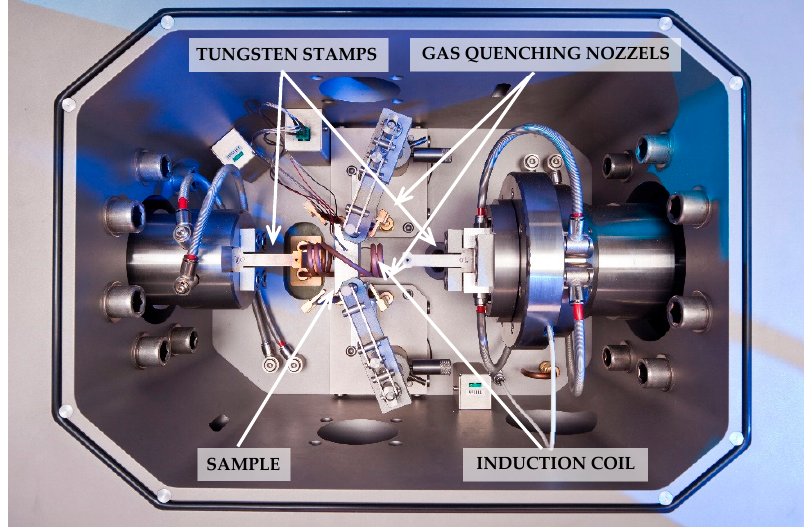
Figure 2. Test chamber of the Thermomechanical Treatment Simulator TTS 820.